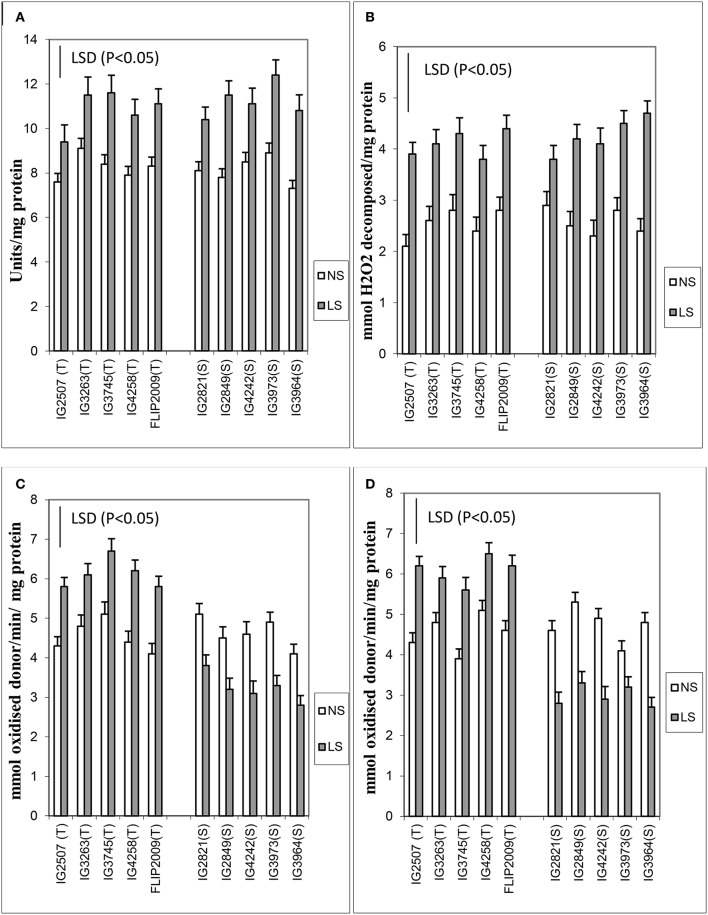
(A) Superoxide dismutase (SOD), (B) catalase (CAT), (C) ascorbate peroxidase (APX), and (D) glutathione reductase (GR) in normal-sown (NS) and late-sown (LS) genotypes. Small vertical bars on histograms represent standard errors. LSD (P < 0.05; represented as small vertical line close to y-axis) for SOD (1.2), CAT (1.6), APX (1.4), and GR (1.8); T, tolerant; S, sensitive.